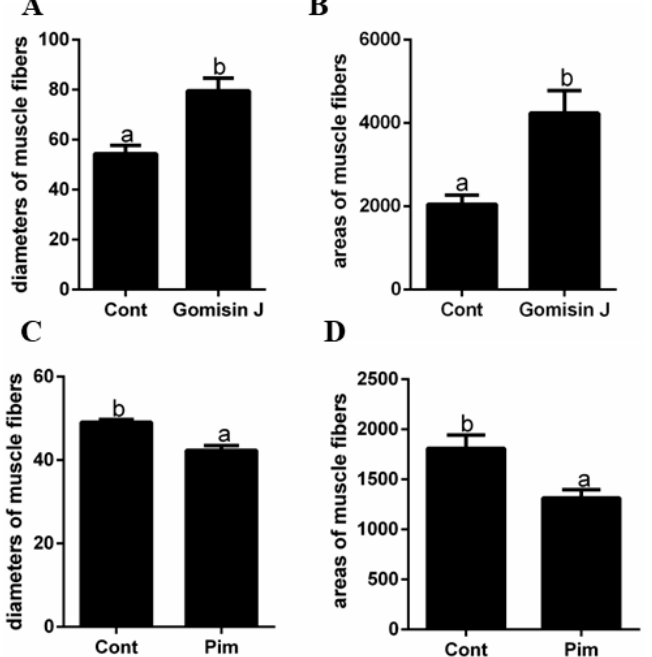
Figure 5. The effects of Pim on triploid crucian carp histological characteristics of muscle fibers. ( A ) The effects of Gomisin J on diameters of muscle fibers at 15 days. ( B ) The effects of Gomisin J on areas of muscle fibers at 15 days. ( C ) The effects of Pim on diameters of muscle fibers at 9 days. ( D ) The effects of Pim on areas of muscle fibers at 9 days. Data are presented as means ± SE ( n = 3). Different letters indicate significant differences ( p < 0.05).